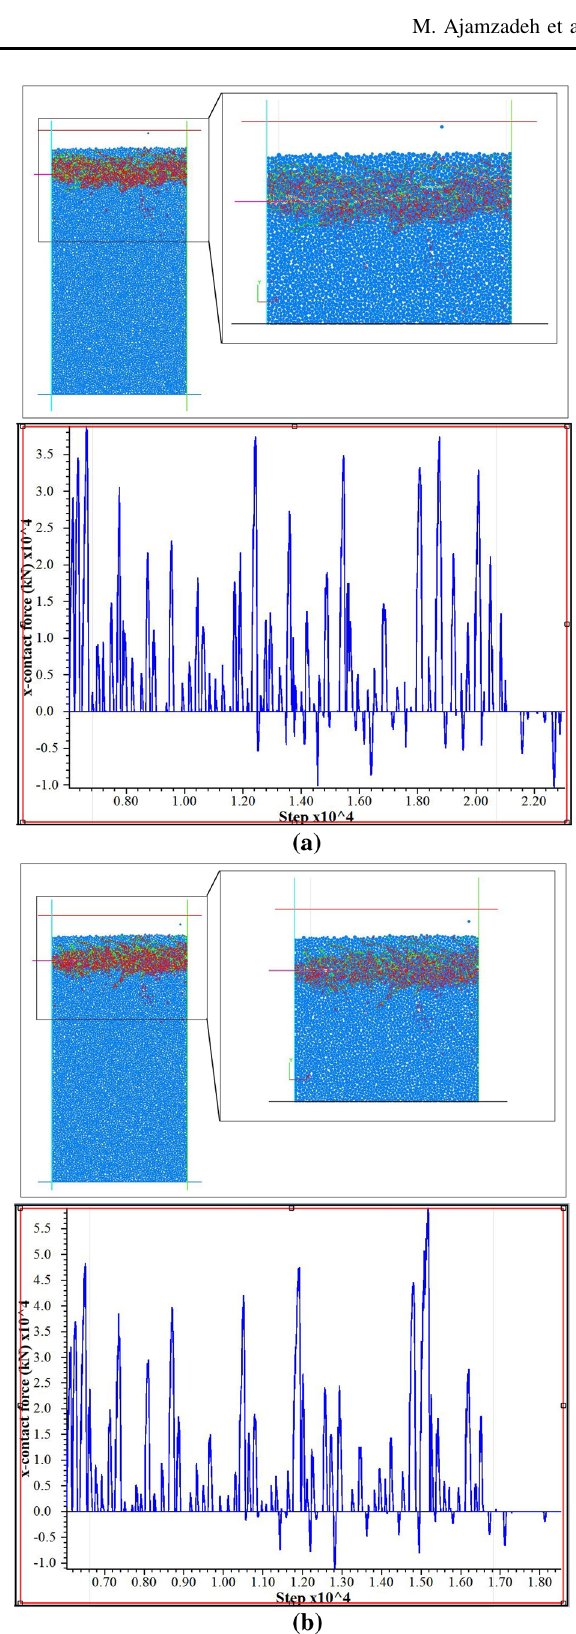
Fig. 7 Results of plow model with zero-degree angle: a Model 1, b Model 2 Fig. 8 Results of plow model with zero-degree angle: a Model 3, b Model